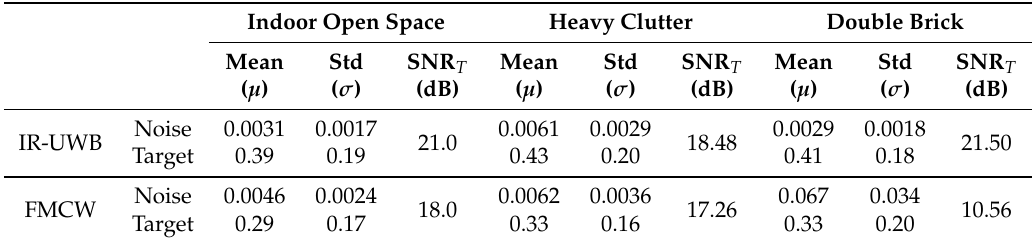
Figure 6. Noise and subject signal distribution of IR-UWB and FMCW radars with one subject of 1.5 m distance in and indoor open space: ( a ) distribution and fitting of noise by IR-UWB radar, ( b ) distribution and fitting of subject by IR-UWB radar, ( c ) distribution and fitting of noise by FMCW radar, and ( d ) distribution and fitting of subject by FMCW radar. Table 3. Statistical Analysis of Noise and Subject